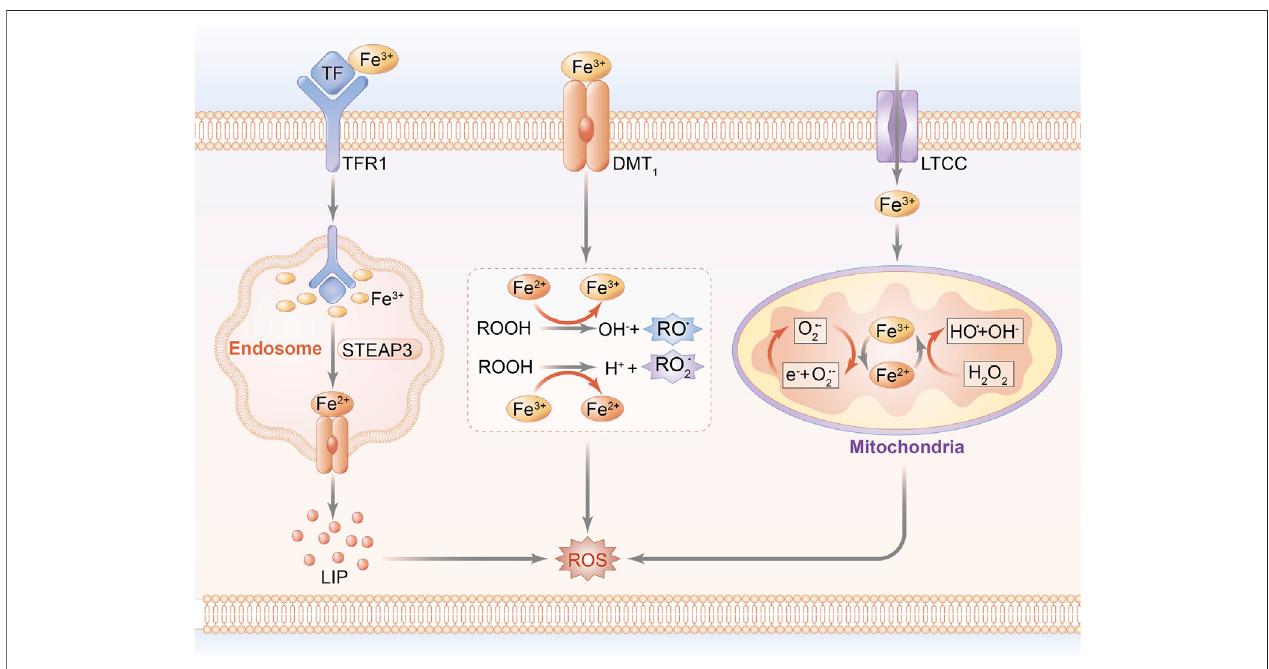
FIGURE 1 | Schematic diagram of iron homeostasis in cardiomyocytes. Peripheral iron is bound with Tf and imported into the intracellular area through the transport of TfR1, while non-Tf – combined iron is transported by DMT-1 and LTCC. The uptake of iron is internalized by endocytosis. A part of iron mediates lipid peroxidation by catalyzing ROOH into the formation of RO and RO 2 radicals. Other parts of Fe(II) and Fe(III) are transported into mitochondria to conduct peroxidative reaction through Fenton reaction, and eventually upregulate ROS generation.; Abbreviations: Tf, transferrin; TfR1: transferrin receptor 1; DMT-1, divalent metal transporter 1; LTCC, L-type voltage-dependent Ca 2+ channels; ROOH, hydroperoxysides; RO, alkoxyl; RO 2 , peroxyl; and STEAP3, STEAP family member 3.